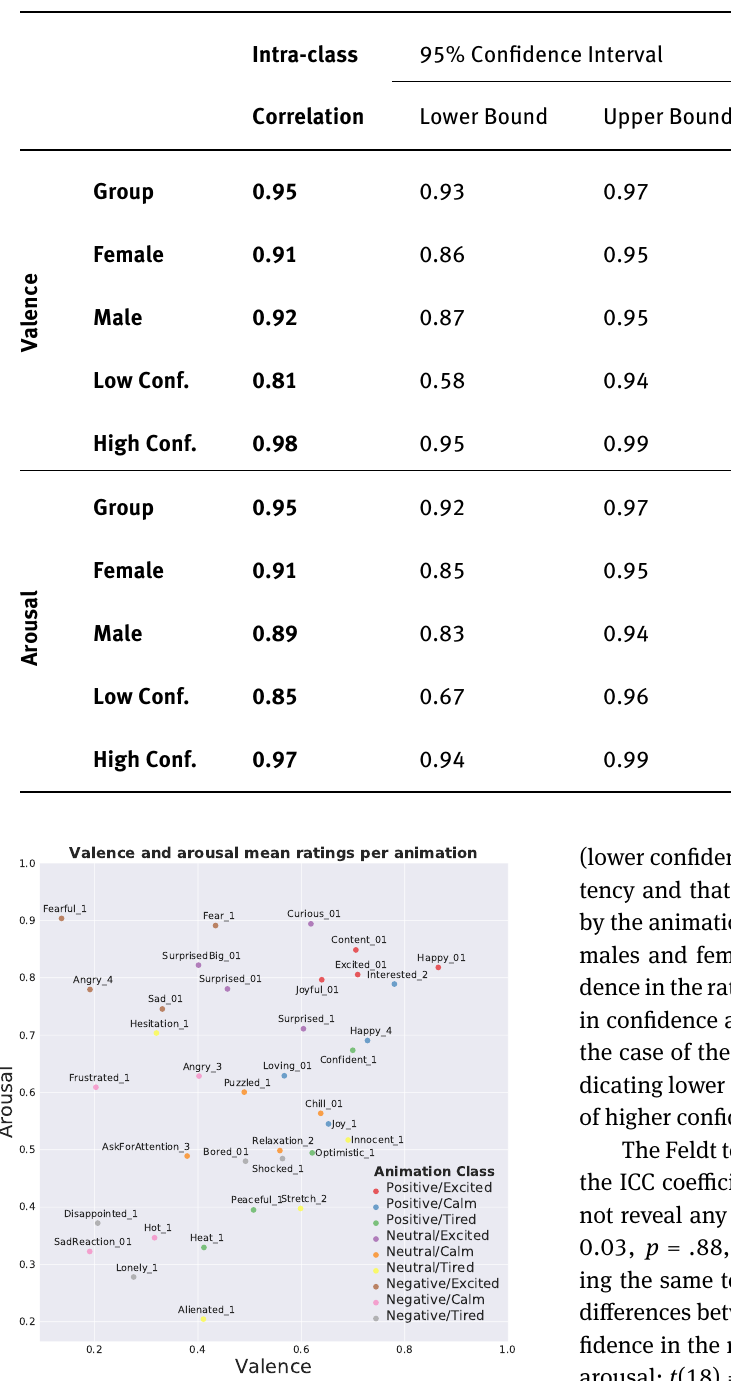
Figure 6: The final set of valence and arousal labels derived from the means across raters. They are plotted with the original categor- ical tags of the animations (given by the animators in the creation phase) and color-coded according to our pre-assigned